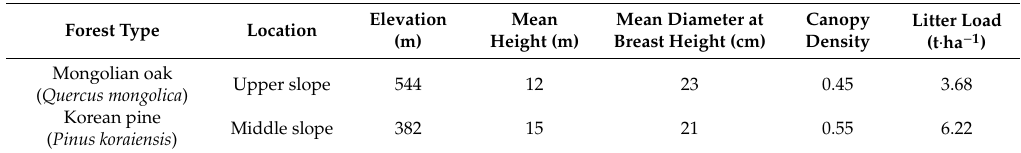
Table 1. Basic information of the two sample plots.